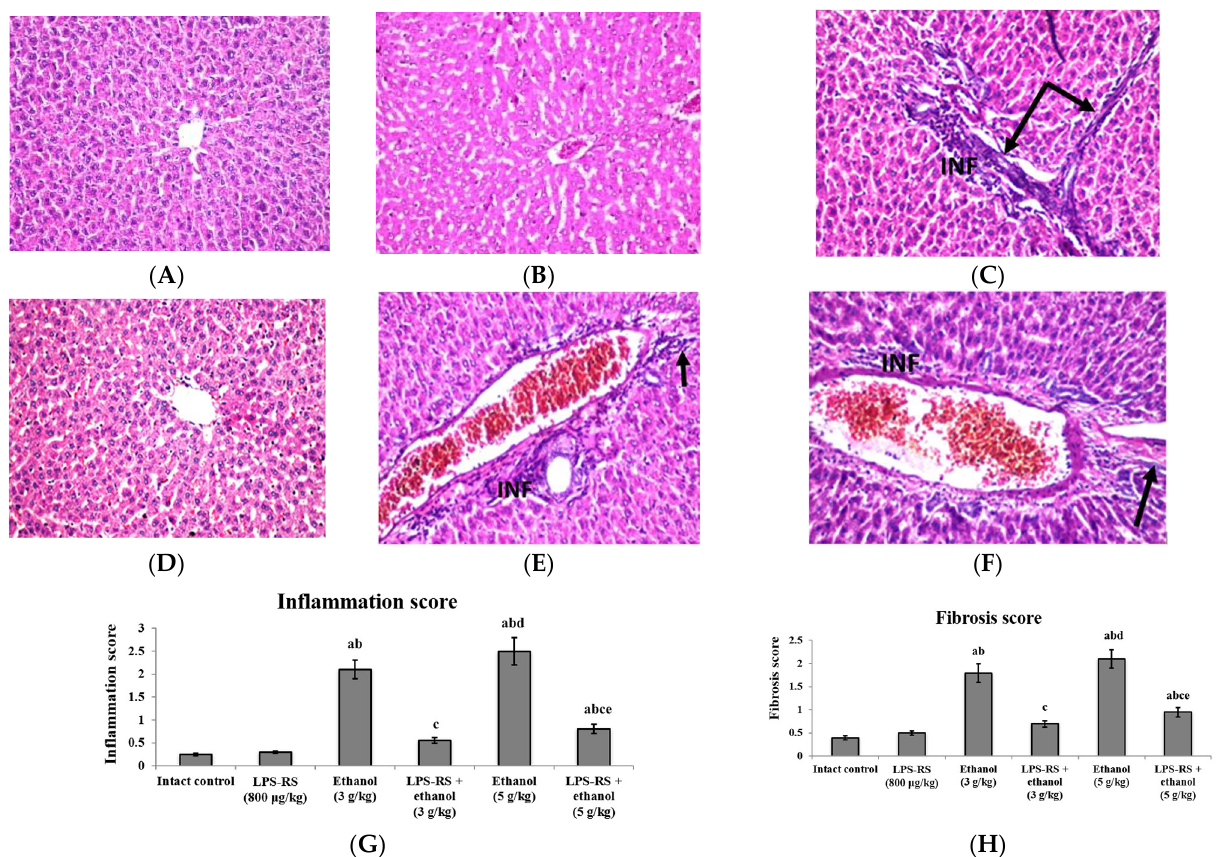
Figure 6. Histopathological sections of rats’ liver stained with hematoxylin and eosin (H&E) (40×). ( A ) intact control group and ( B ) LPS-RS group; showing intact superficial layer, normal population and orientation of hepatocytes, ( C ) rats receiving ethanol (3 g/kg); dilation was observed in the central vein associated with inflammatory cells infiltration (INF) and fibrosis (black arrows) in the portal area, ( D ) LPS-RS + ethanol (3 g/kg) group; showing almost normal histopathological structure, ( E ) rats receiving ethanol (5 g/kg); the portal area showed congestion in the portal vein with fibrosis (black arrow) and few inflammatory cells infiltration (INF), diffuse Kupffer cells proliferation as well as diffuse inflammatory cells infiltration (INF) were detected in between the hepatocytes, ( F ) LPS-RS + ethanol (5 g/kg) group; dilation and congestion were detected in the central veins with few inflammatory cells infiltration (INF) in the portal area, ( G ) Inflammation score, and ( H ) fibrosis score. Scores are expressed as mean ± SD and analyzed using one-way ANOVA followed by Bonferroni’s post-hoc test ( n = 8–10). Differences were considered significantly different at p < 0.05. a vs. intact control; b vs. LPS-RS; c vs. ethanol (3 g/kg); d vs. LPS-RS + ethanol (3 g/kg); e vs. ethanol (5